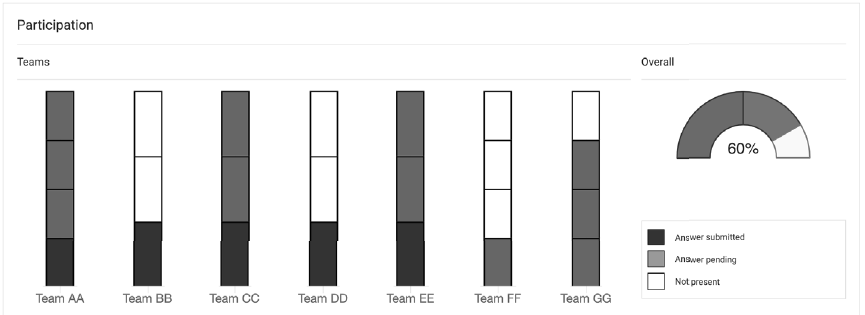
Fig. 1. Real-time overview of team participation shown while a quiz is